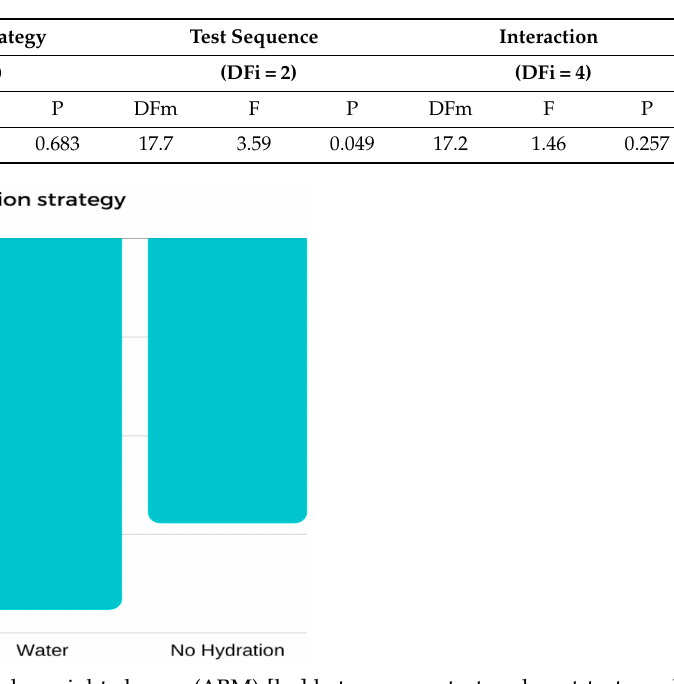
Figure 3. Mean values of body weight change ( ∆ BM) [kg] between pre-test and post-test results performed using three different hydration strategies: marginal means. Table 3. Results of analysis of variance for the change in body mass ( ∆ BM) between the pre-test (preT) and post-test (postT) results of the exercise test: significance of (P) and F-statistic along with the number of degrees of freedom (DFi—in the numerator; DFm—in the denominator) for the fixed effects (hydration strategy, test sequence, and their interaction).